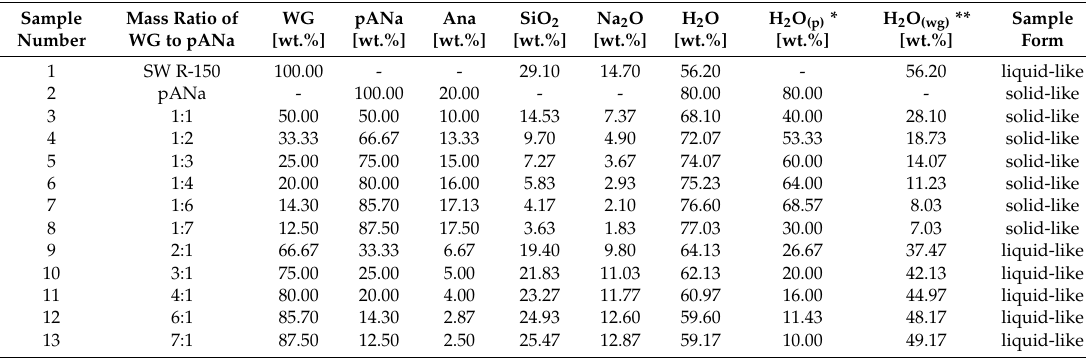
Table 1. Composition of the tested polymer-silicate